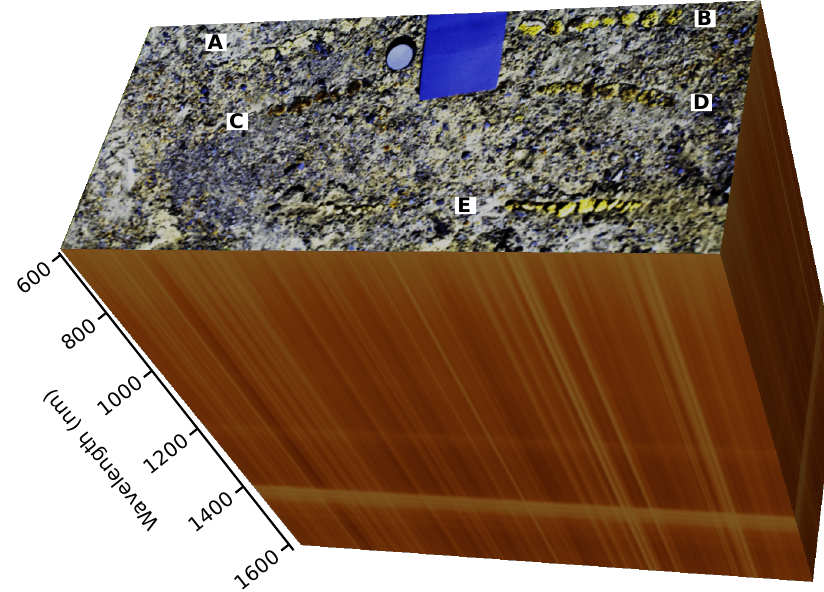
Figure 2. Example hyperspectral cube with false-color composite constructed from bands at 970 nm (red), 875 nm (green) and 600 nm (blue). Round structures (partly greenish depending on the species) are biological soil crusts. Samples of the locally-dominating species were manually arranged in rows: A: Acarospora cf. gypsi-deserti , B: Caloplaca santessoniana , C: Placidium cf. velebiticum